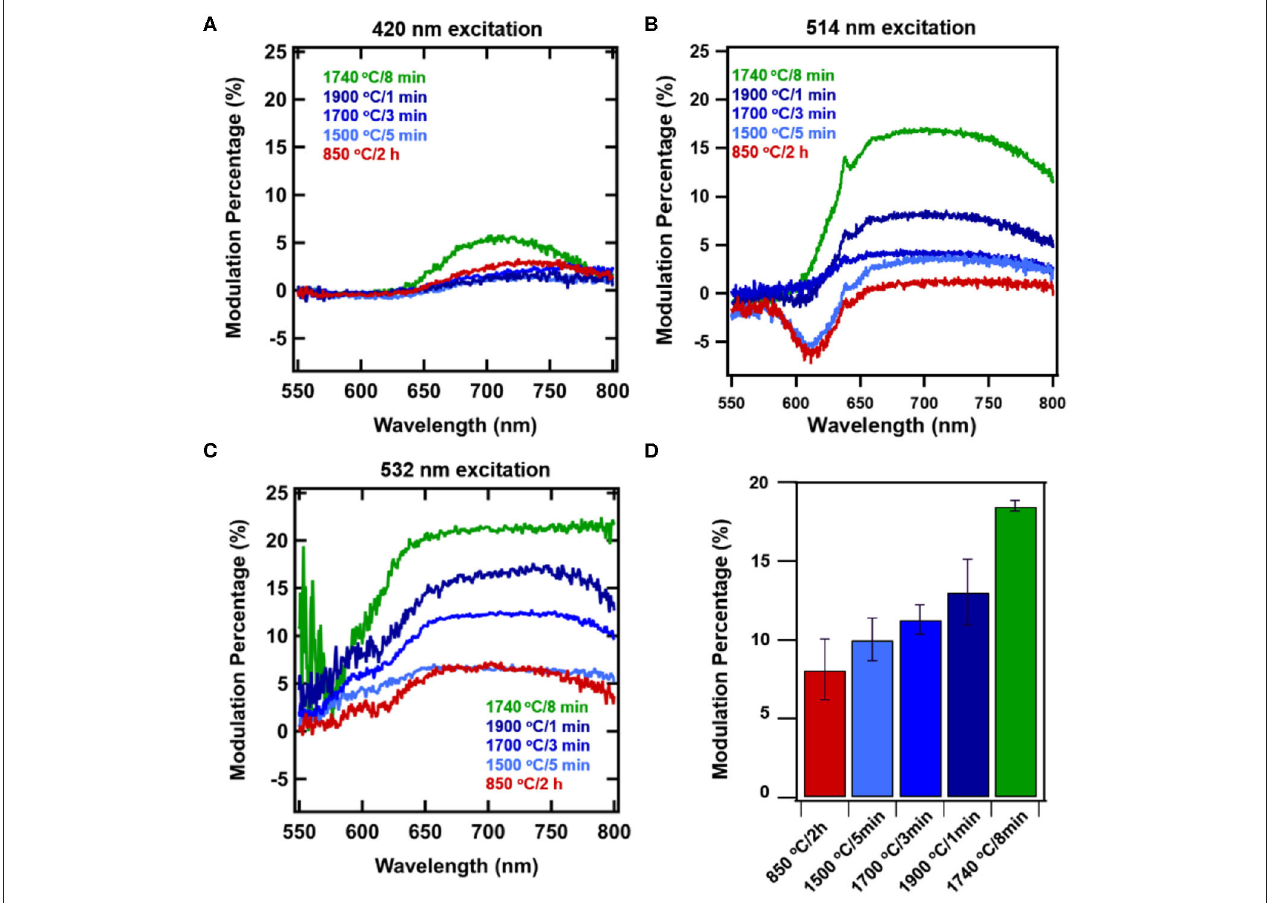
FIGURE 3 | Wavelength-dependent magnetically induced fluorescence contrast due to application of a static magnetic field to systematically treated diamond samples: standard treatment (850 ◦ C/2h), 1500 ◦ C/5min, 1700 ◦ C/3min, and 1900 C/1min, and high performing 1740 o C/8min for excitation wavelengths (A) 420nm, (B) 514nm, and (C) 532nm. Error bars represent average of 3 measurements each for 3 spots. (D) Modulation contrast collected for imaging under 532 excitation with 650nm